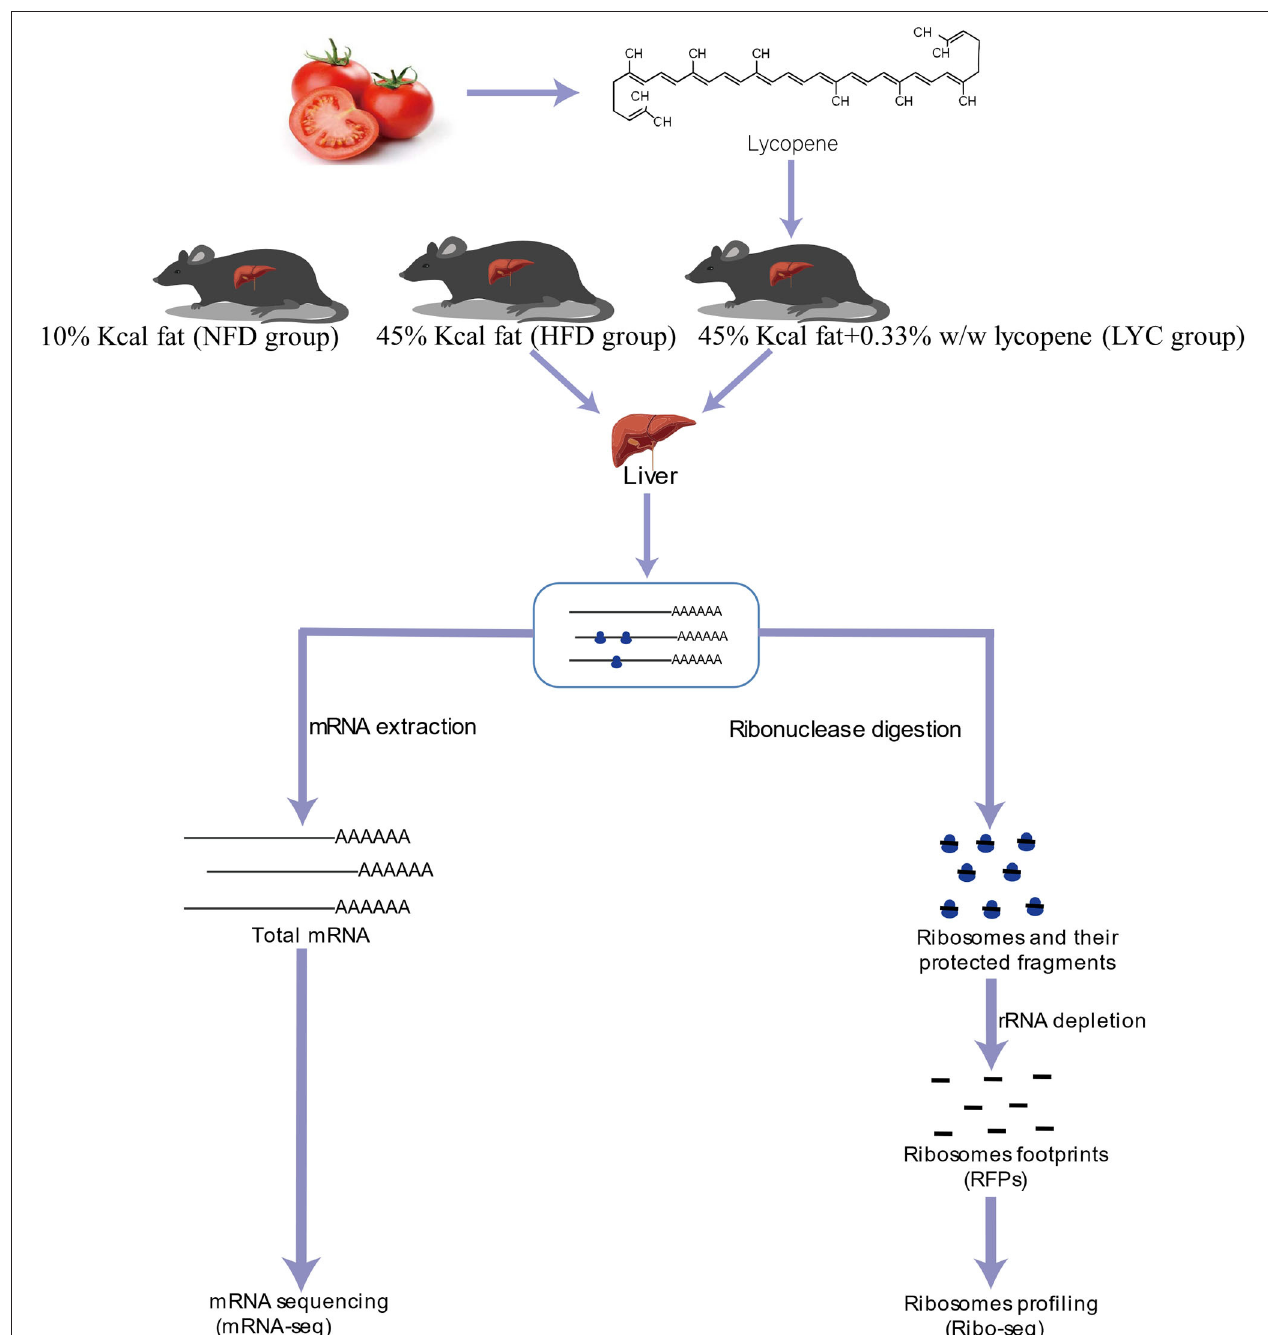
FIGURE 1 | Schematic of the study design and high-throughput